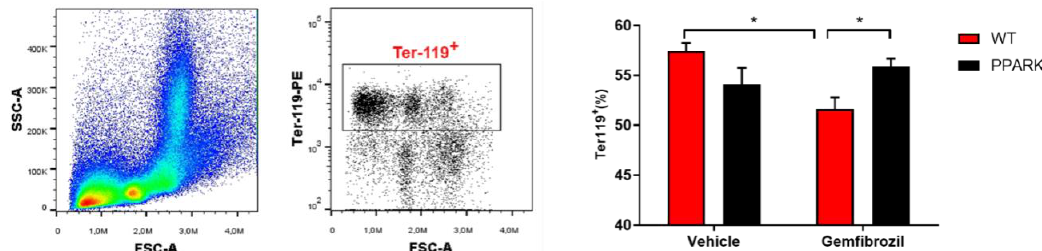
Figure 3. Gemfibrozil treatment decreased erythroid cells, and PPAR-alpha deletion blunted it. Ter-119+ is an erythroid marker. Gating strategy for Ter-119+ and quantification are presented. Data presented as mean ± SEM; n = 5–6 per group. Two-way ANOVA followed by Tukey’s post hoc test. * p < 0.05.